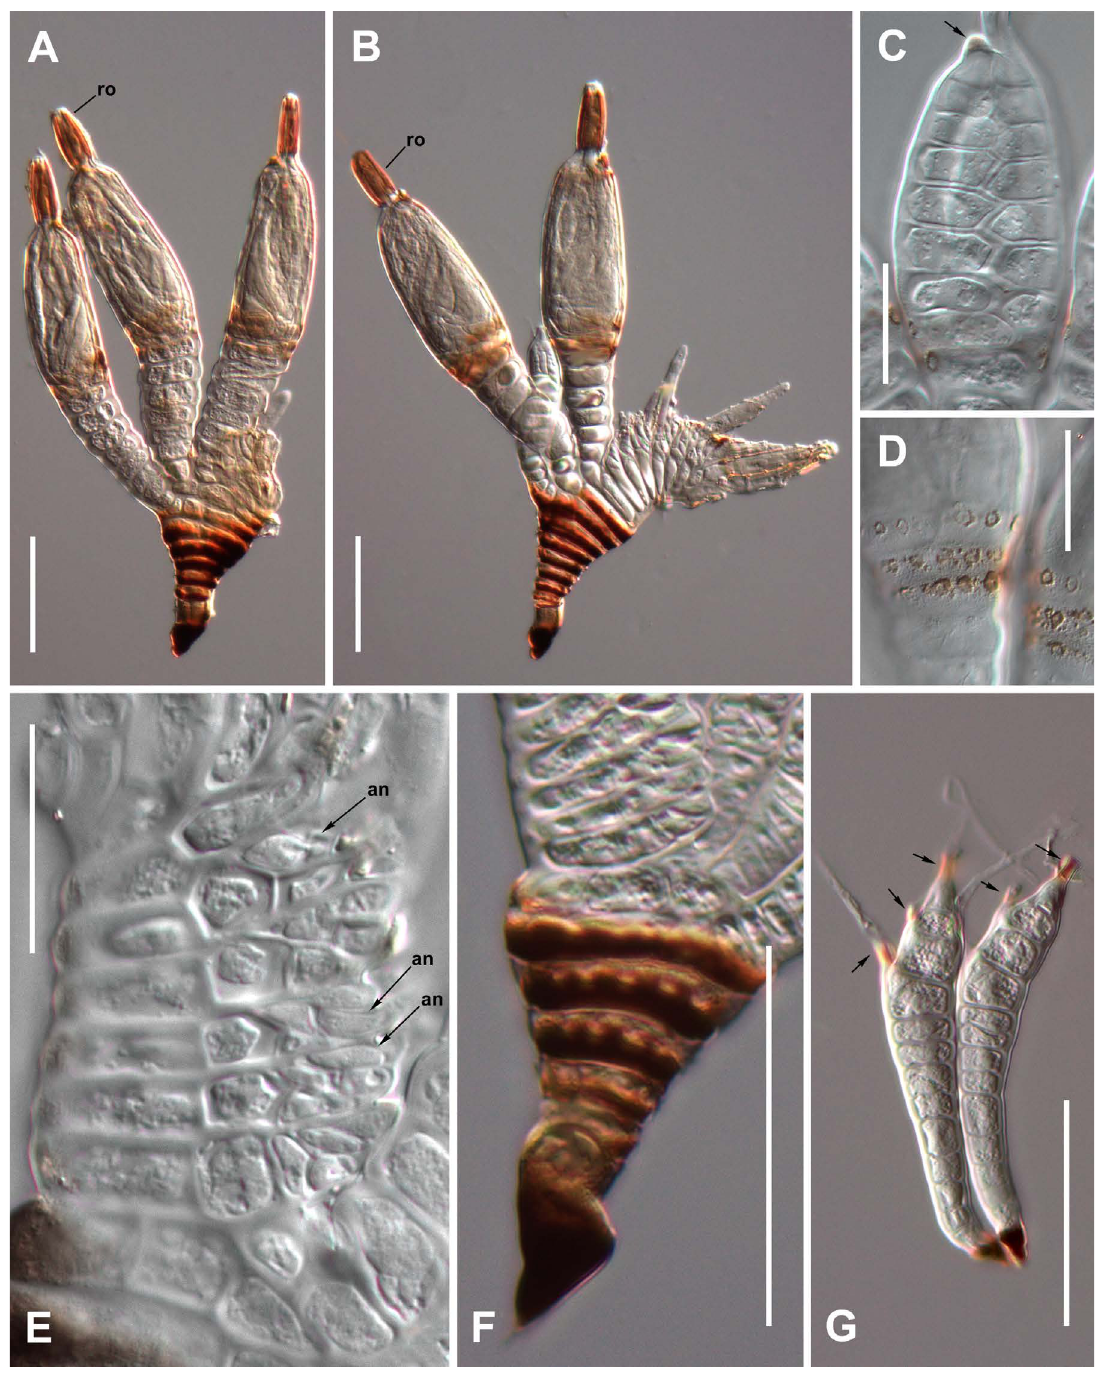
Fig. 6. A – F . Kainomyces isomali Thaxt. A – B . Mature thalli showing the rostrum (ro) on the perithecia. C . Detail of an immature perithecium showing numerous wall cells for each row and the subterminal outgrowth on the perithecium. D . Detail of basal area of perithecium showing brown spots. E . Detail of receptacle with antheridia (an). F . Detail of the lower receptacle showing comb-like pigmentation. – G . Hydrophilomyces atroseptatus T.Majewski. Young thallus where darkened septa on the base of secondary branchlets are arrowed. Scale bars: A–B, F–G = 50 µm; C–E = 20 µm. Photographs from slides ZMUC C-F-124250 (A), ZMUC C-F-124252 (B), ZMUC C-F-124002 (C–F), and ZMUC C-F- 123693